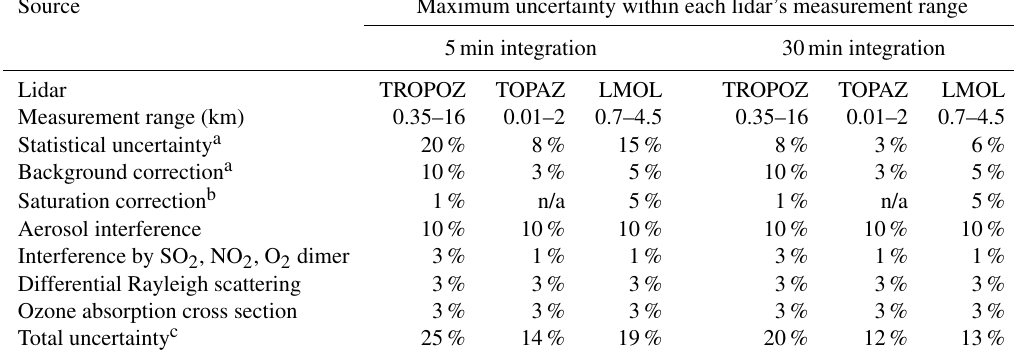
Table 2. Maximum 1 σ uncertainties for TROPOZ, TOPAZ, and LMOL daytime ozone measurements within their measurable range for the 5 and 30min integration